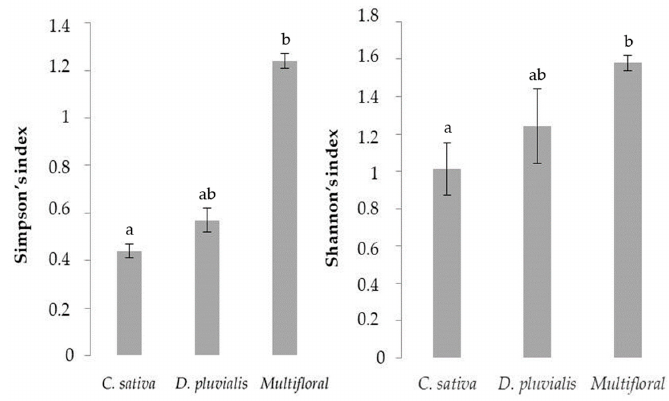
Figure 2. Bar plots of mean values of both Simpson and Shannon indexes for the different treatments. The different letters represent a significant difference calculated from the post-hoc Dunn’s test comparison ( p -value < 0.05).